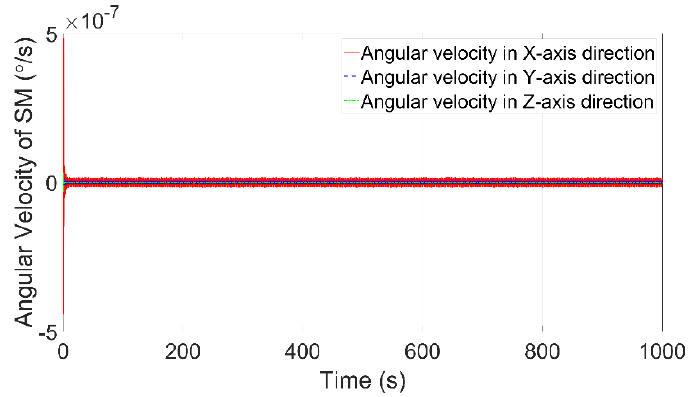
Figure 12. Attitude angular velocity of the SM.